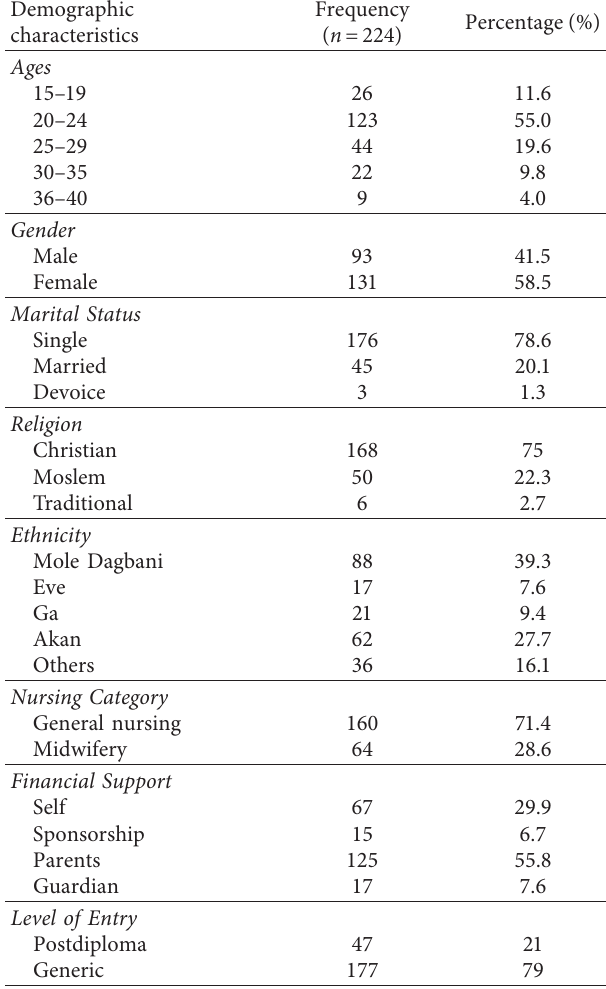
Table 1: Demographic characteristics of